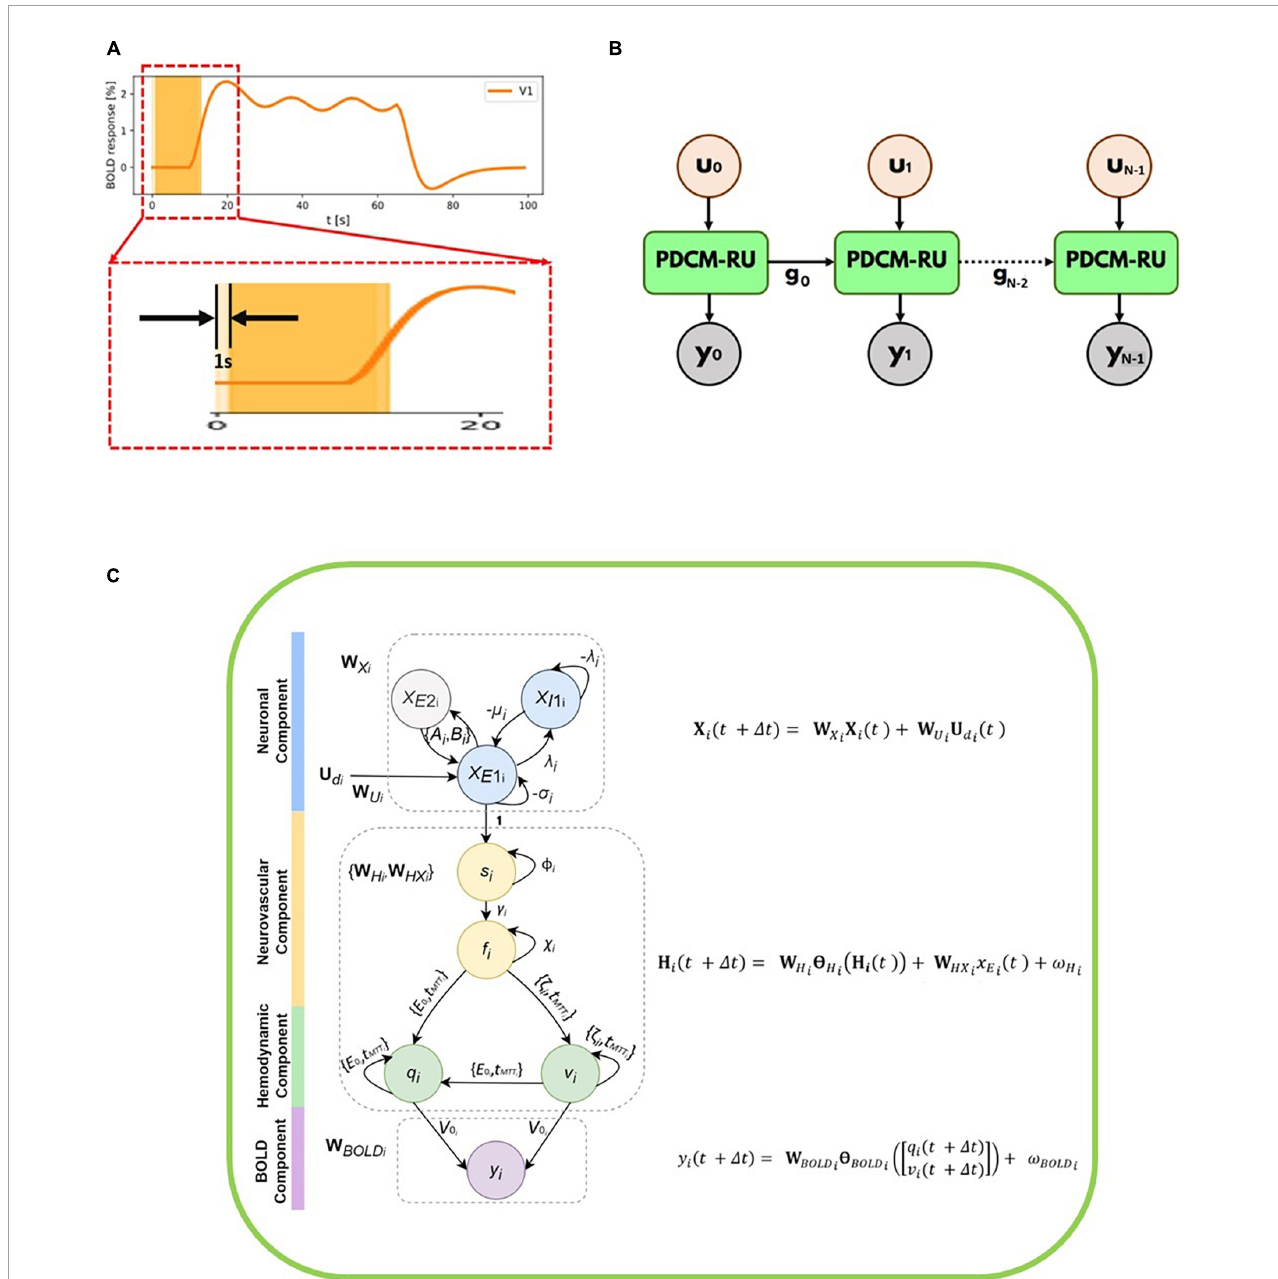
FIGURE1 (A) Simulated BOLD fMRI time-courses for R1 along with two overlapping windows each of 12 s duration which moves from left to right. The time course between 0 and 20 seconds has been magnified to show the overlap of two successive windows. The stride of each overlapping window is 1 s. (B) Unfolded version of the discretized Physiologically informed Dynamic Causal Model ( d PDCM)-recurrent unit (RU) architecture through time. For i th window for which the input is u i and the output is y i . The set of hidden variables from the 0 th window, g 0 are being fed to the next window. Thus, a recurrence is followed and the same unit with different parameter values is being repeated time and again till the final window. (C) Overall schematic representation of each d P-DCM recurrent unit consisting of neuronal, neurovascular, hemodynamic, and blood oxygenation level-dependent (BOLD) components. These components include respective latent variables, whose states are updated according to the associated equations (shown on the right, also refer to Equation 8). x E 2 i and x E 1 i refer to excitatory populations from regions 1 to 2, respectively. These regions are connected at the excitatory level. For each region, an inhibitory population exists, given by x I 1 i . Neuronal responses are the resultant of neuronal activity (due to the application of input stimulus) generated at the neuronal component. These excitatory responses induce vasoactive signals s i , which increase the